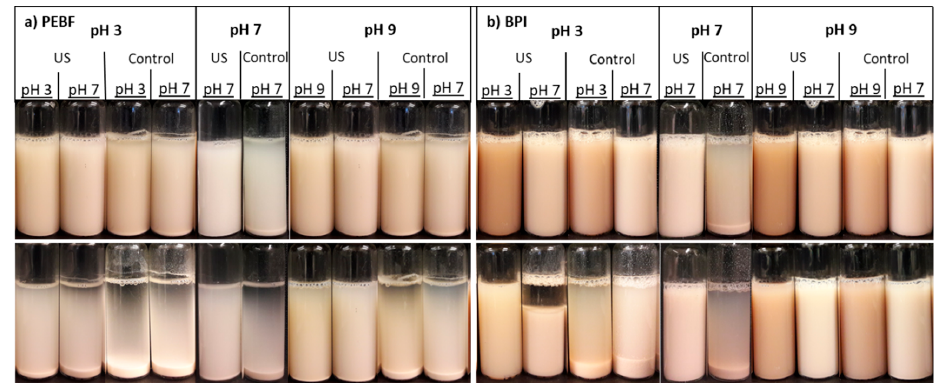
Figure 5. Impact of ultrasound treatment and pH on colloidal stability of ( a ) protein-enriched barley fraction (PEBF) and ( b ) barley protein isolate (BPI) dispersions at 1.5% ( w/w ) solid content after 10 min (upper row) and 180 min (lower row) of standing. The first text row indicates pH-value of the ultrasound/control treatment, the second row indicates whether the ultrasound treatment was performed for the sample or not, and the third row shows the colloidal stability analysis pH.